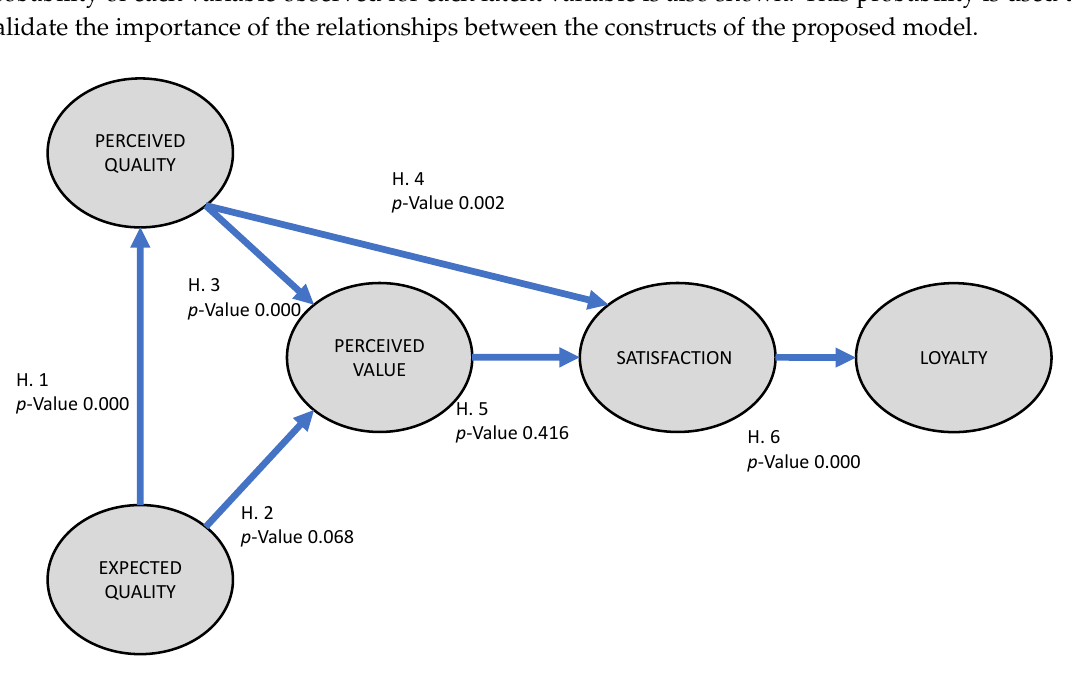
Table 9. Hypothesis testing.